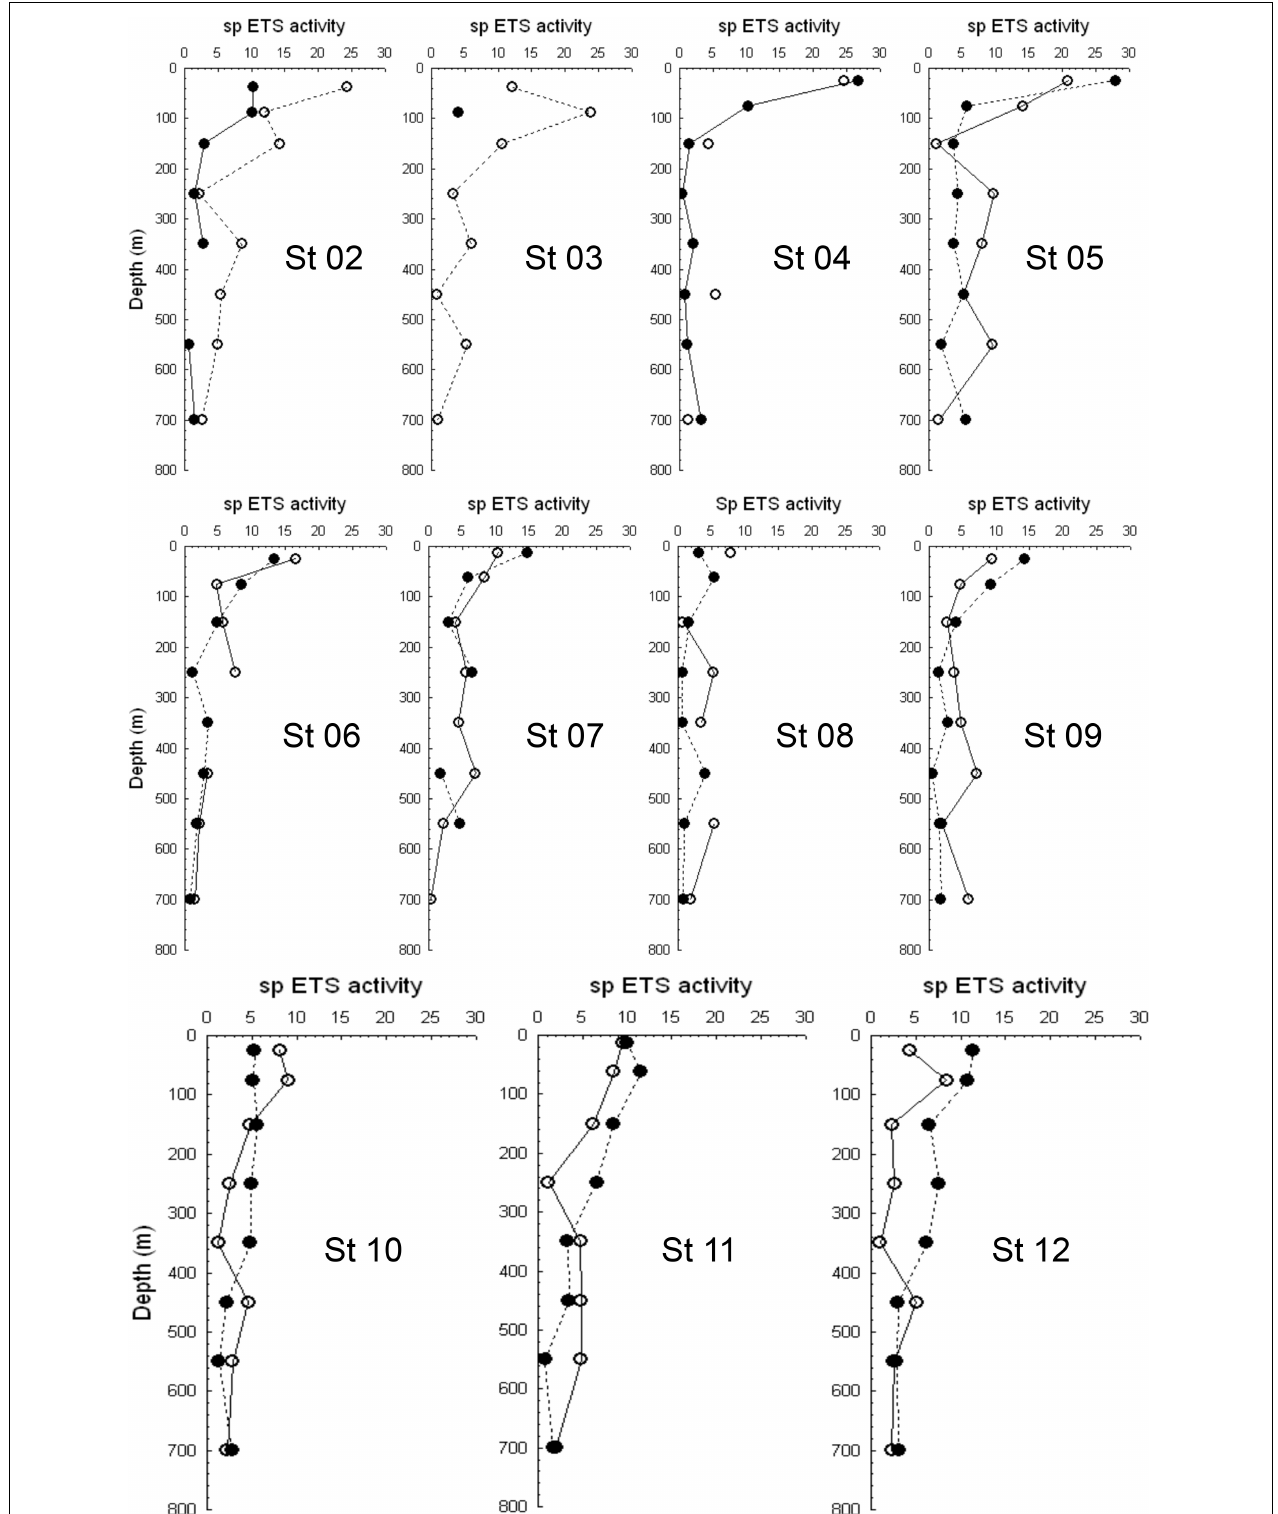
FIGURE 6 | Vertical profiles of zooplankton ETS activity (in µ lO 2 · mg protein − 1 · h − 1 ) along the transect. Empty dots are daylight activity values, while black dots are nighttime ETS activity.